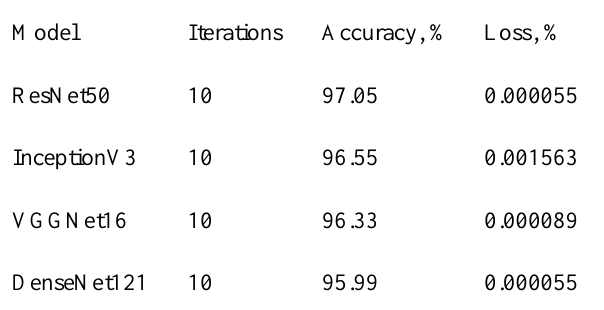
Table 1 Comparison of training accuracies of the evaluated